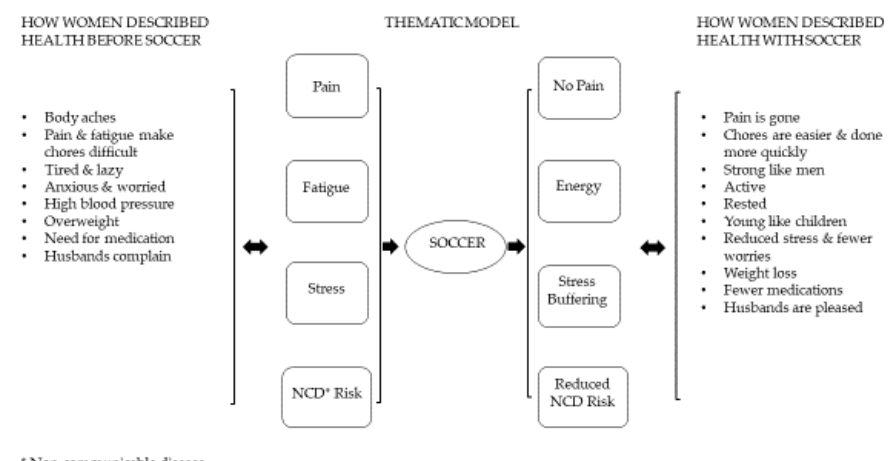
Figure 1. Thematic model derived from focus group discussions.